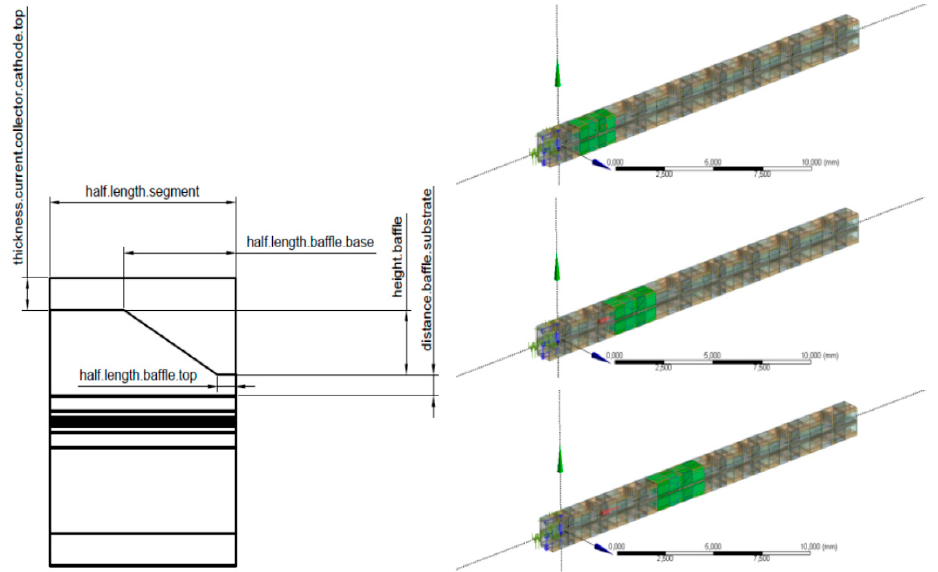
Figure 10. Parameters ( left ) and scalable segments 2, 3, and 4 ( right from top to bottom ).